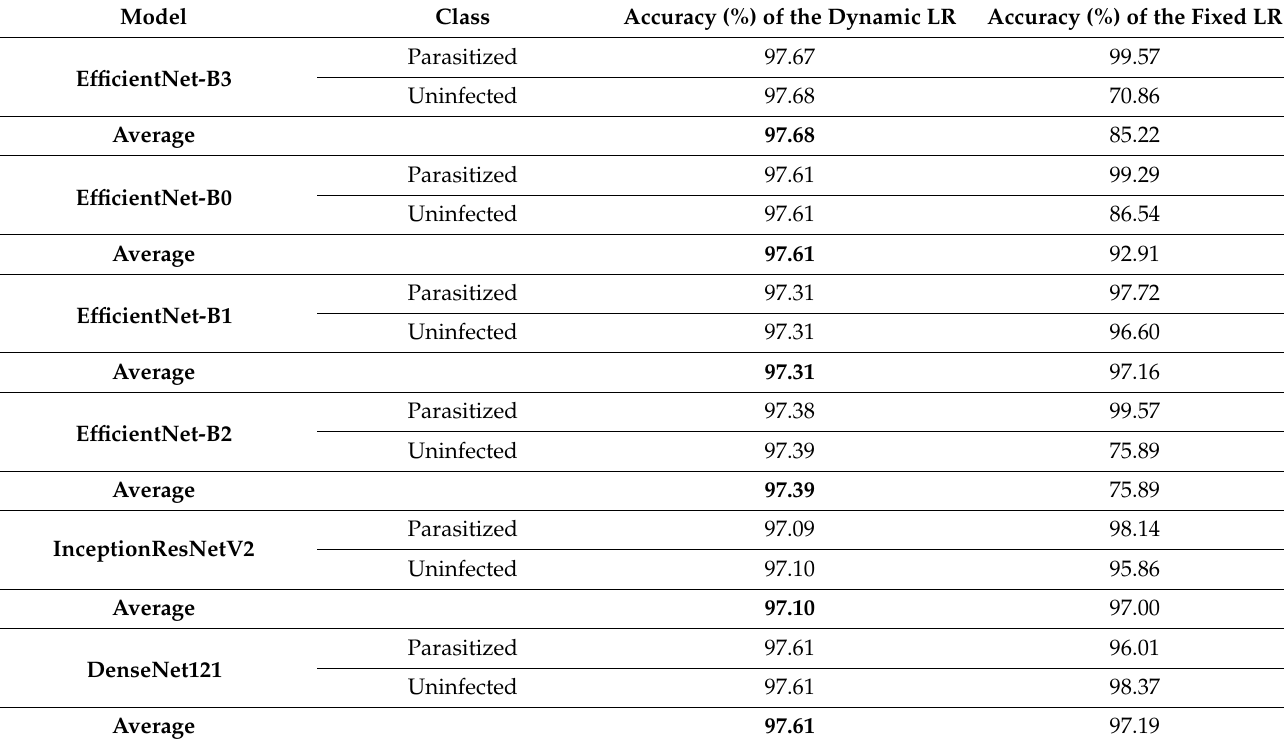
Table 7. Comparison of accuracy of the six CNN models using the proposed dynamic LR and using the fixed LR for malaria